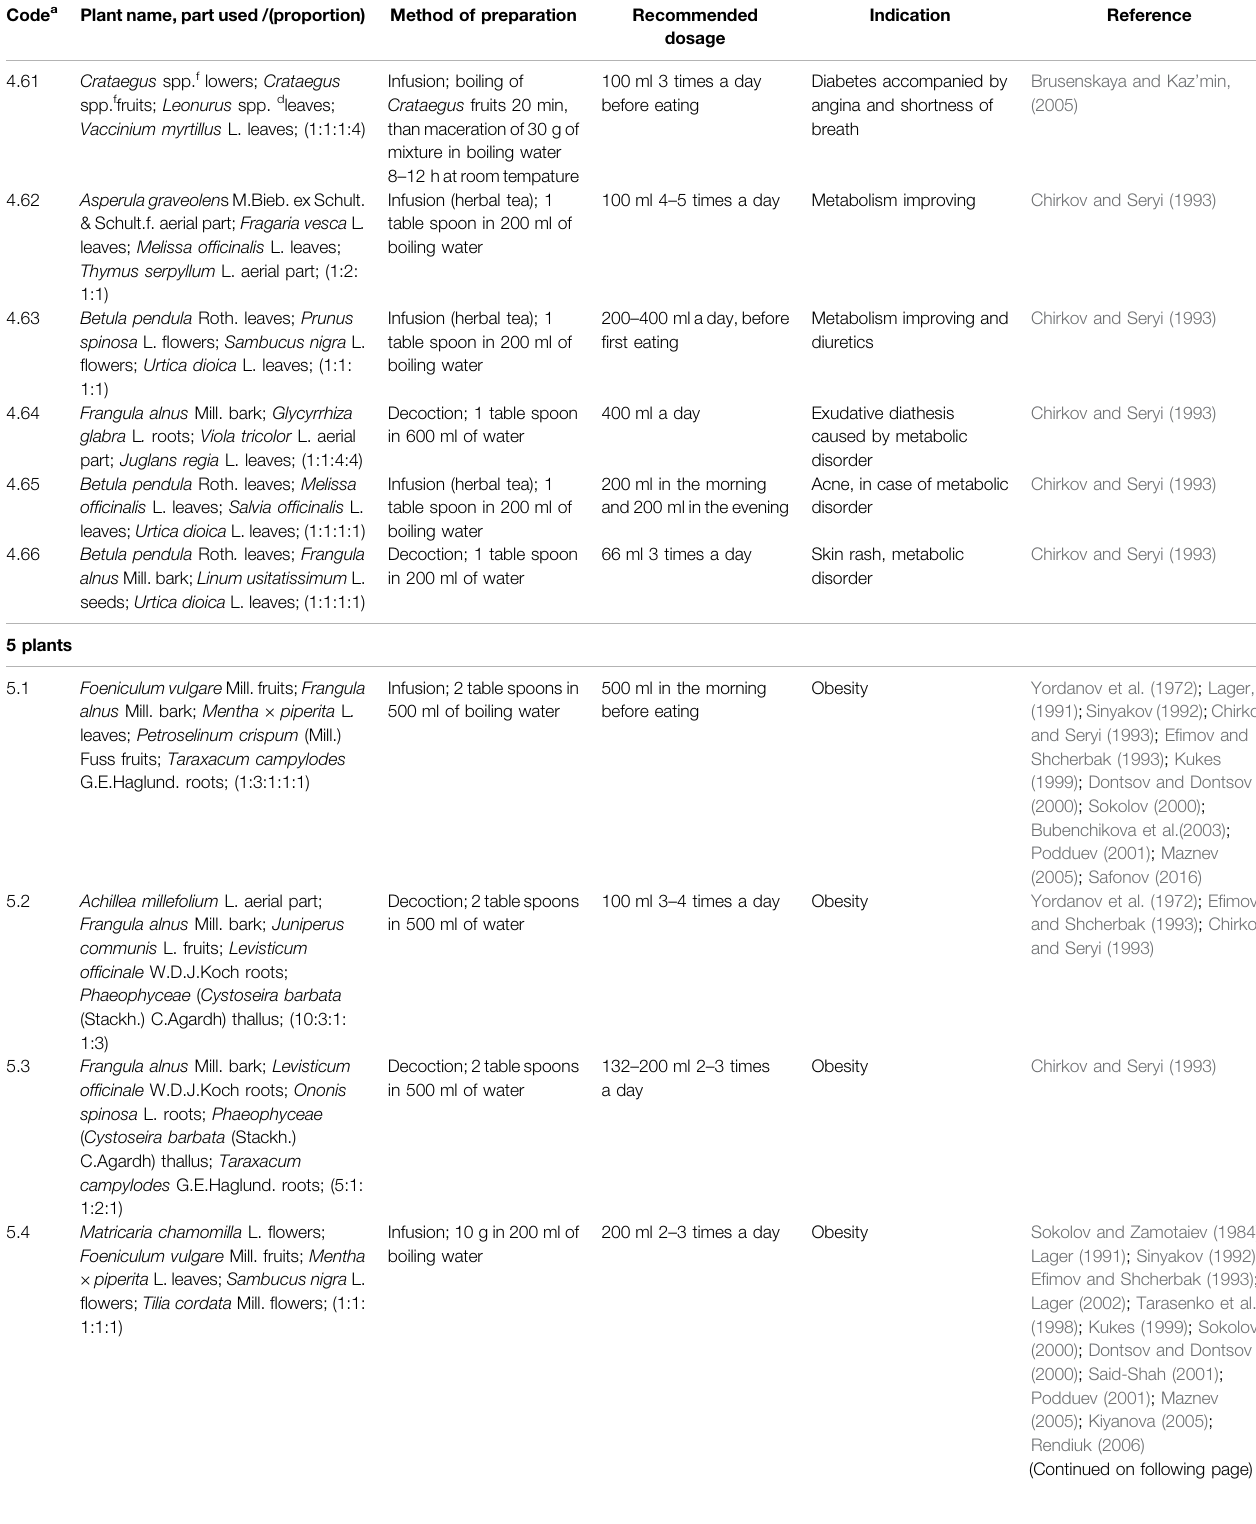
TABLE 1 | ( Continued ) The list of medical species used for the management of diabetes and related disorders in Russia. Code a Plant name, part used /(proportion) Method of preparation Recommended